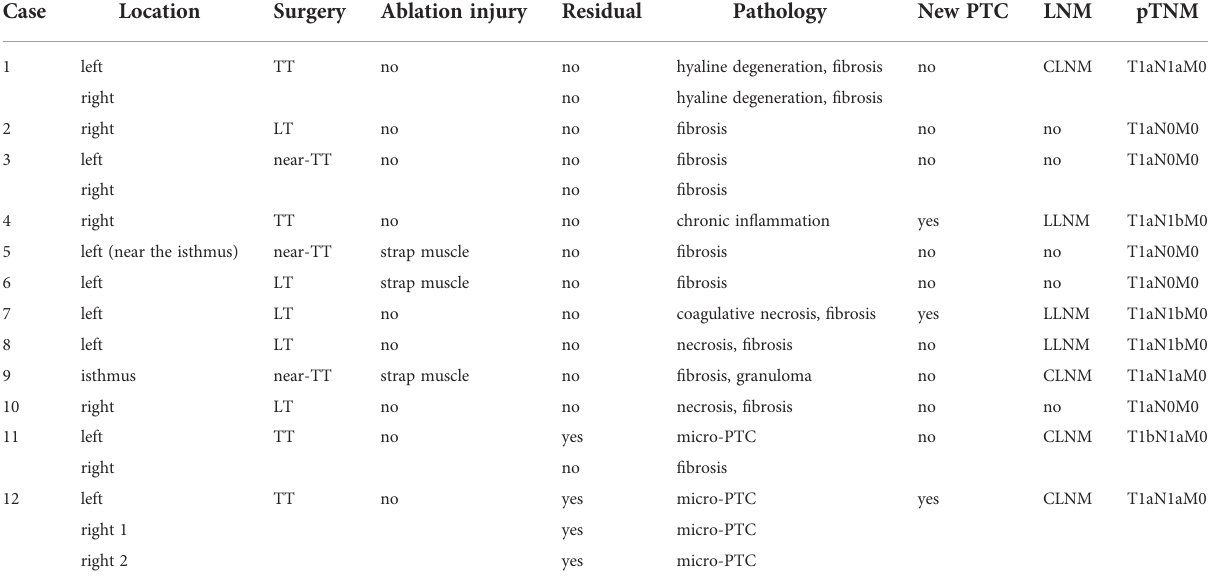
TABLE 2 Intraoperative fi ndings and postoperative pathology